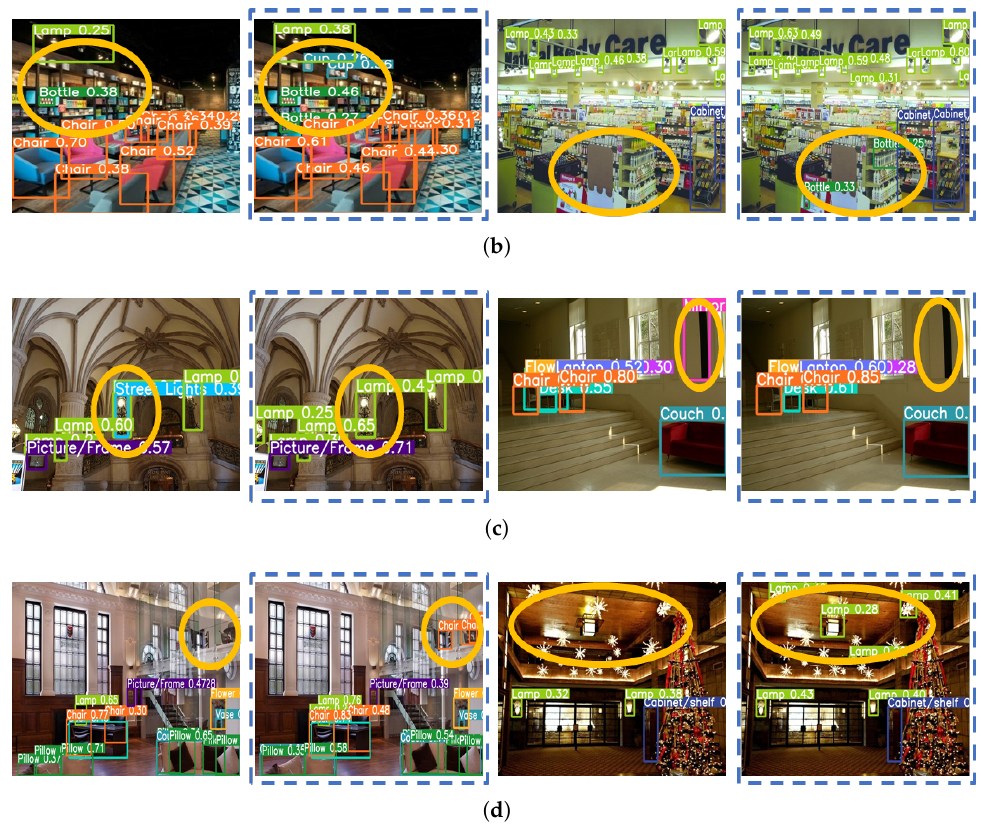
Figure 10. Object detection results of S-ODF (the image on the left from each pair of images) and M-ODF (image on the right with the dotted line from each pair of images) for each environment: ( a ) Bookstore, ( b ) Drugstore, ( c ) Entrance hall, and ( d )